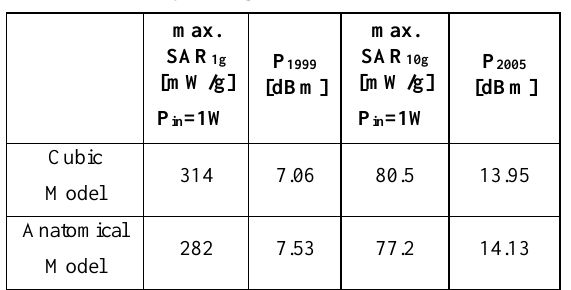
Table 1. Safety performance of the ingestible antenna operating at 403.5 MHz.